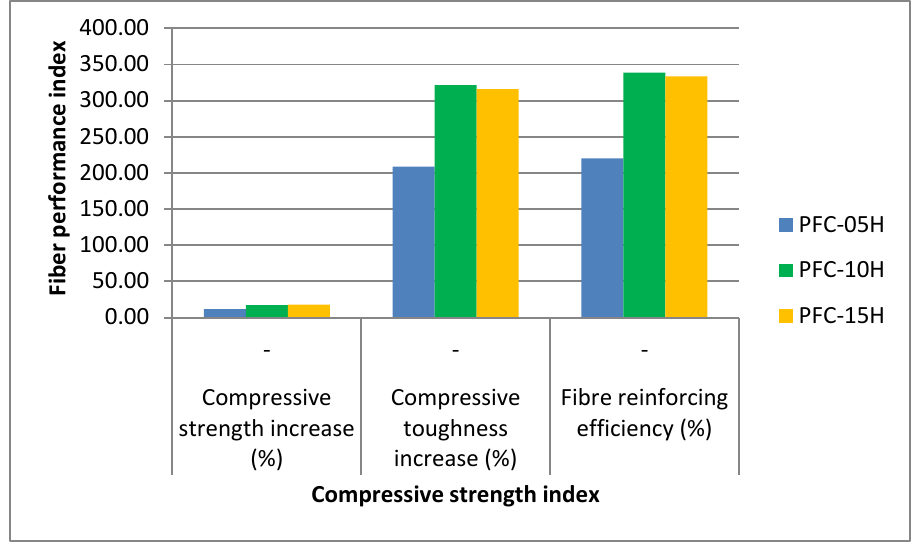
Figure 12. Relationship between the compressive strength index vs. fiber performance index.